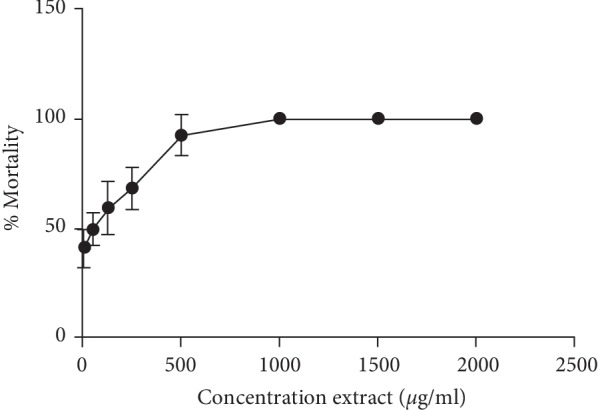
Mortality percentage (%) curve of brine shrimp exposed to different concentrations of methanolic extract of Coleus amboinicus.